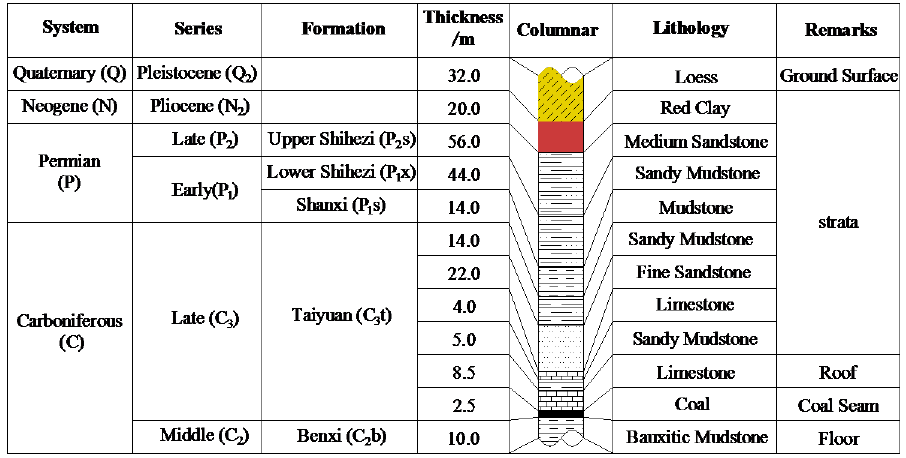
Figure 3. The typical stratigraphic column in the mining